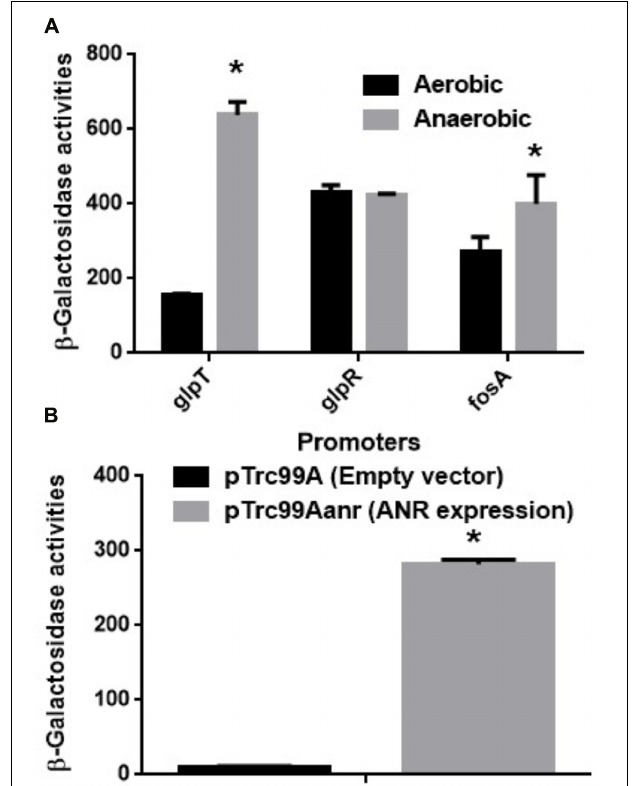
FIGURE 2 | (A) β -Galactosidase activities of PAO1 containing pBBRglpT(PAO1)-P, pBBRglpR(PAO1)-P or pBBRfosA(PAO1)-P, the lacZ reporter plasmid grown under aerobic or anaerobic conditions. (B) β -Galactosidase activities correspond to glpT promoter activities of PAO1 in E. coli MC4100, the heterologous host containing pNNglpT(PAO1)-P, the lacZ reporter plasmid with pTrc99A (empty vector) or pTrc99Aanr ( anr expression plasmid). Data plotted are the means from three independent experiments; error bars indicate the standard deviations, ∗ P < 0.01. Asterisks denote significance for values of glpT promoter activity in PAO1 cultured under anaerobic conditions relative to those under aerobic conditions or in MC4100 with anr gene expression relative to those without anr gene